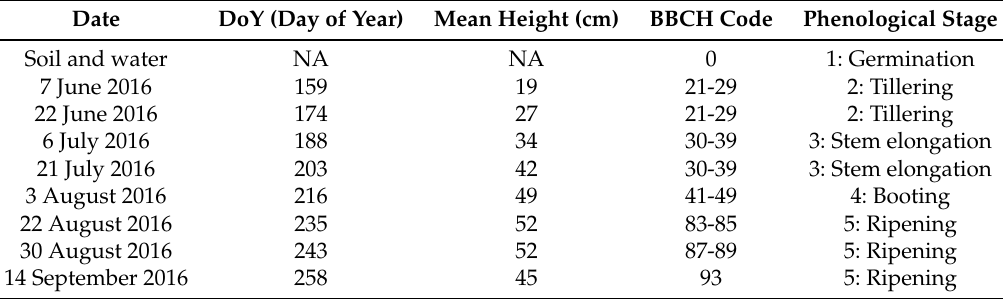
Table 1. BBCH code and phenology stage of each observed data set.